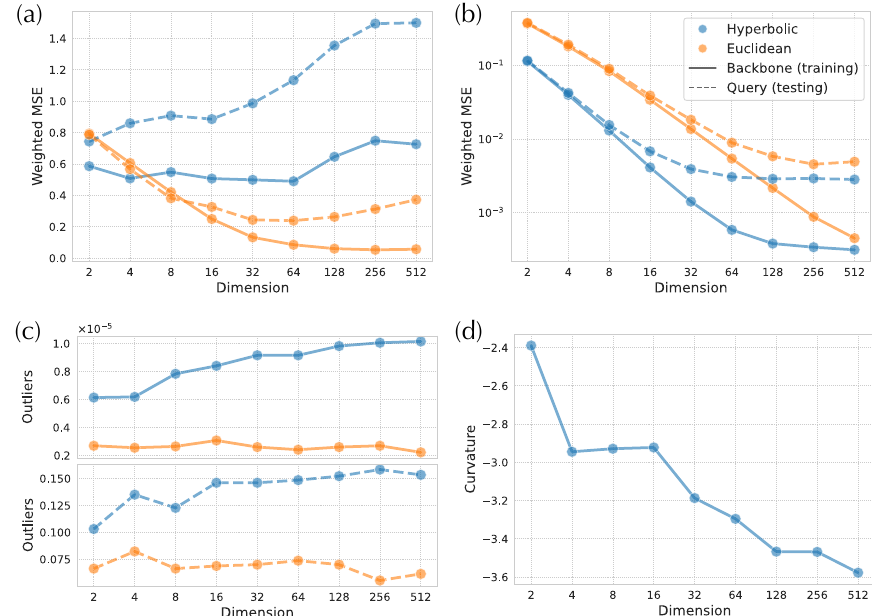
Figure 6. Examination of distortion on the 16S WoL dataset. ( a , b ) Weighted MSE for five smallest distances from each query ( a ) and all other distances ( b ). ( c ) Proportion of outliers among distances between pair of backbone species ( top ) and query and backbone species ( bottom ). Outliers: distances with weighted square error larger than 100; We remove outliers in either Euclidean distances or Hyperbolic distances for MSE calculation. ( d ) Curvature of Hyperbolic